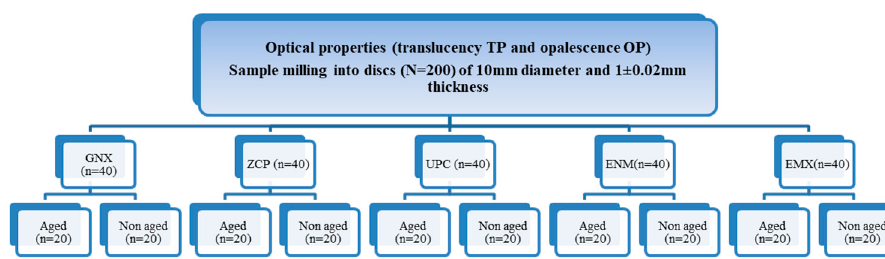
Figure 1. Flowchart of workflow for testing the samples.